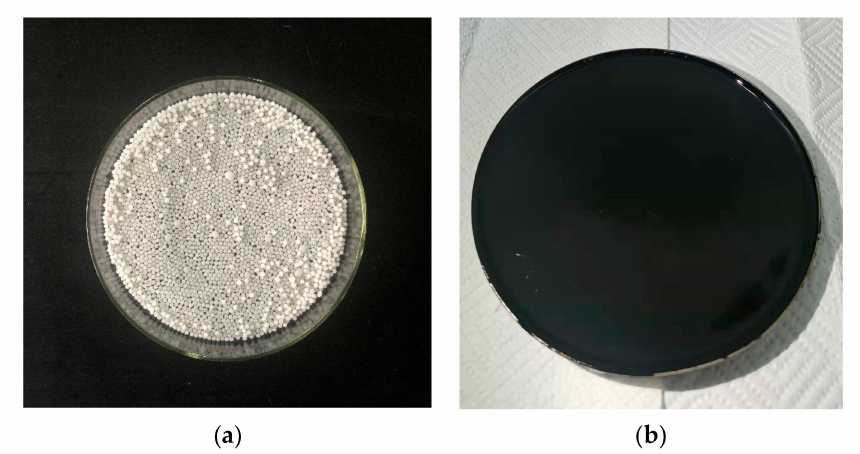
Figure 1. WS-1 and WMRA: ( a ) WS-1; ( b ) WMRA. Table 1. Physical properties and compositions of base asphalt.